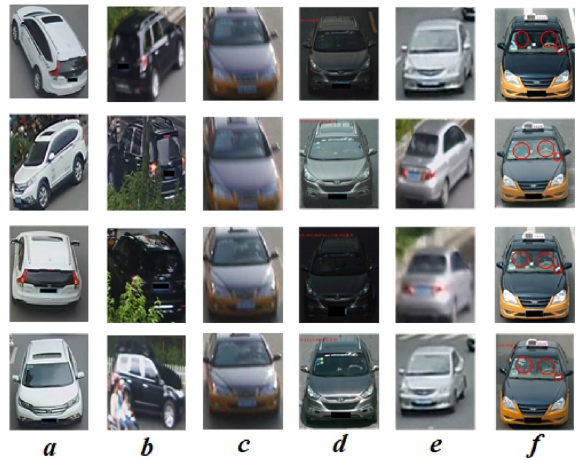
Figure 1. Illustration of challenges in vehicle re-id. The vehicle images( a – e ) in each column are collected with the same vehicle, but their appearances are quite different due to various challenging factors, e.g., viewpoints, illumination, occlusion, low resolution and motion blur. The last column( f ) illustrates the challenges of different vehicle identities with extremely similar appearance, where the red circles indicate the differences in local